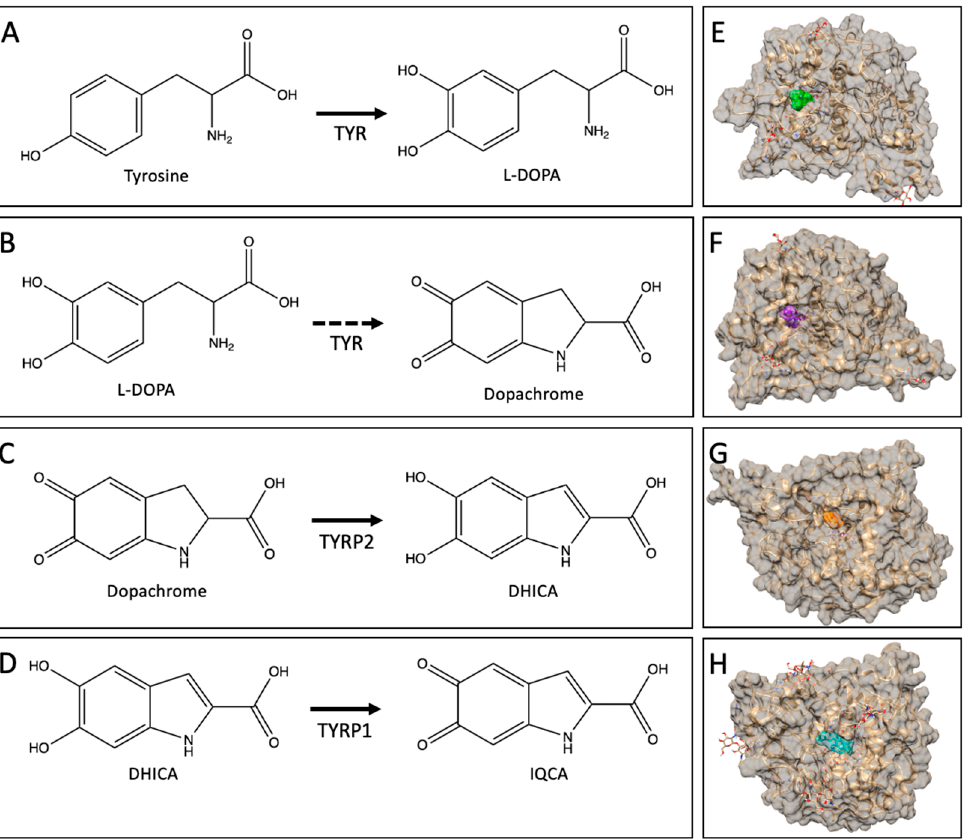
Figure 1. Key steps in melanogenesis pathway. ( A ) TYR catalyzes the conversion of tyrosine to L-DOPA. ( B ) TYR catalyzes L-DOPA to the intermediate dopaquinone (not pictured) to dopachrome. ( C ) TYRP2 catalyzes the conversion of dopachrome to DHICA. ( D ) TYRP1 catalyzes the conversion of DHICA to IQCA. The reactions are labeled as follows: TYR + L-DOPA, diphenol oxidation, and spontaneous conversion of dopaquinone to dopachrome; TYRP2 + dopachrome, dopachrome tautomerization; TYRP1+ DHICA, the oxidation of DHICA to IQCA. Panels E–H are visualizations done in CHIMERA (Version 1.15.0) with the surface of tyrosinases shown in beige. ( E ) Tyrosine, shown in green, docked to the active site. ( F ) L-DOPA, shown in purple, is docked in the active. ( G ) Dopachrome, in orange, is docked in TYRP2. ( H ) DHICA, shown in cyan, is docked to TYRP1.